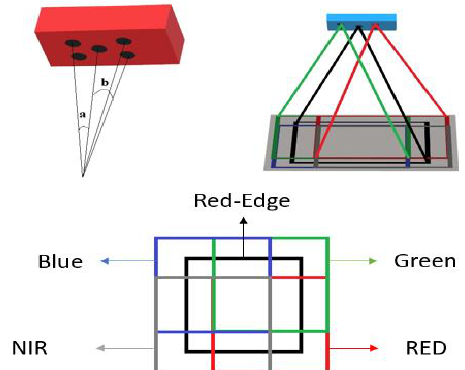
Figure 6. Miss registration in multi-spectral images